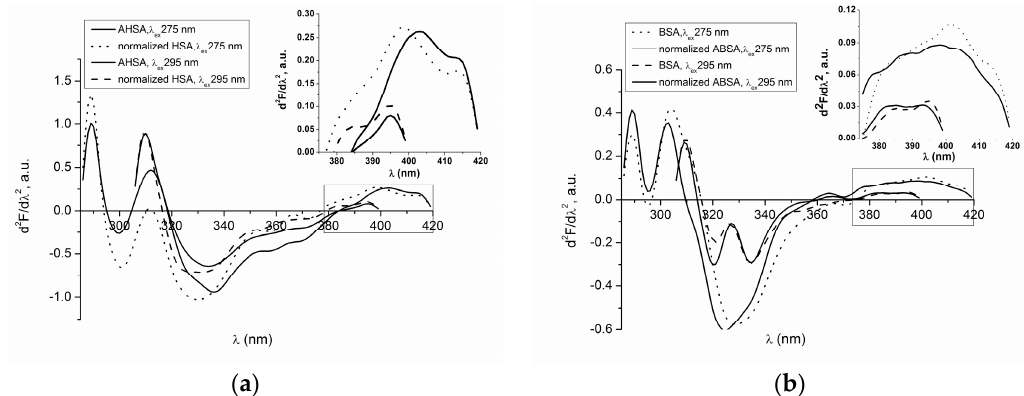
Figure 3. Second derivative fluorescence spectra of normalized and aged isomers of ( a ) human (HSA) and ( b ) bovine (BSA) serum albumin excited at 275 nm and 295 nm, in the insert: second derivative fluorescence spectra of albumin ( λ > 370 nm) derived from Trp residue(s).